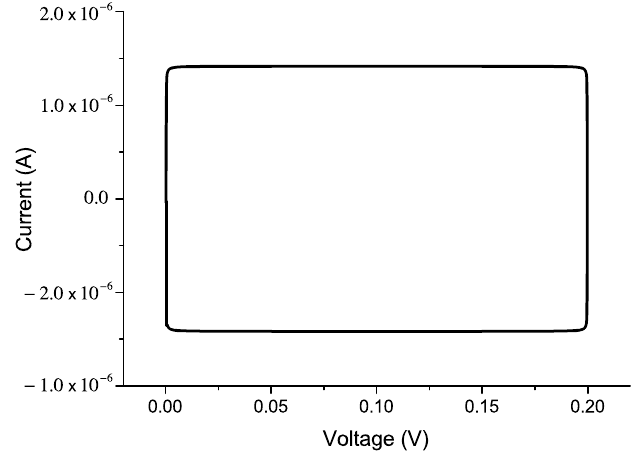
Figure 2. Parametric curves I ( V ) for an electrolytic cell with identical electrodes having the same adsorption properties for positive and negative ions, when the screening parameter is b = 0.04, in the absence of adsorption ( k = 0), with τ = 1 s. In this case, the parametric curve is independent of the desorption time, and it is typical for an ideal